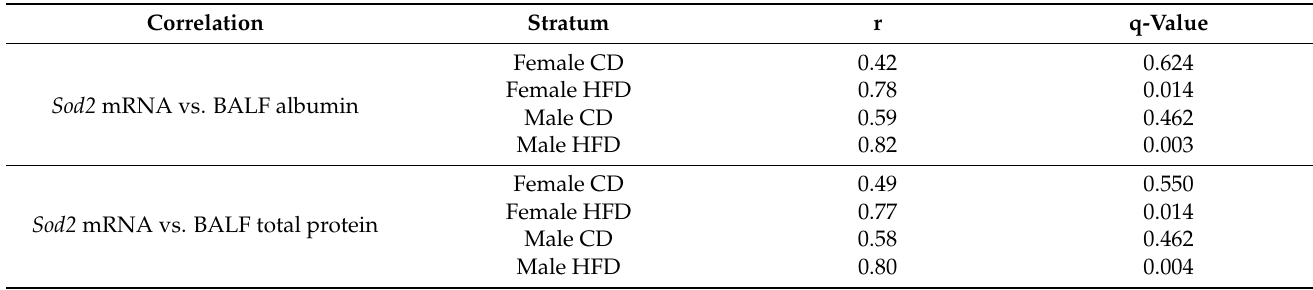
Sod2 mRNA vs. BALF